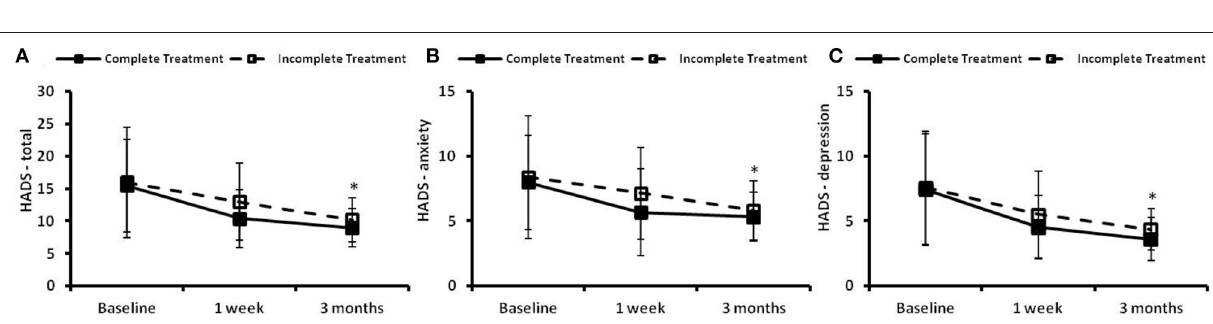
FIGURE 4 | The pre-sleep arousal scale (PSAS) at the preintervention baseline, and 1 week and 3 months following cognitive behavioral treatments for insomnia (CBTI). (A) PSAS-total; (B) PSAS-somatic; (C) PSAS-cognitive. * and # indicate significant differences ( p < 0.05) for the time effect and group effect, respectively. Complete treatment group, n = 58; incomplete treatment group, n = 77.